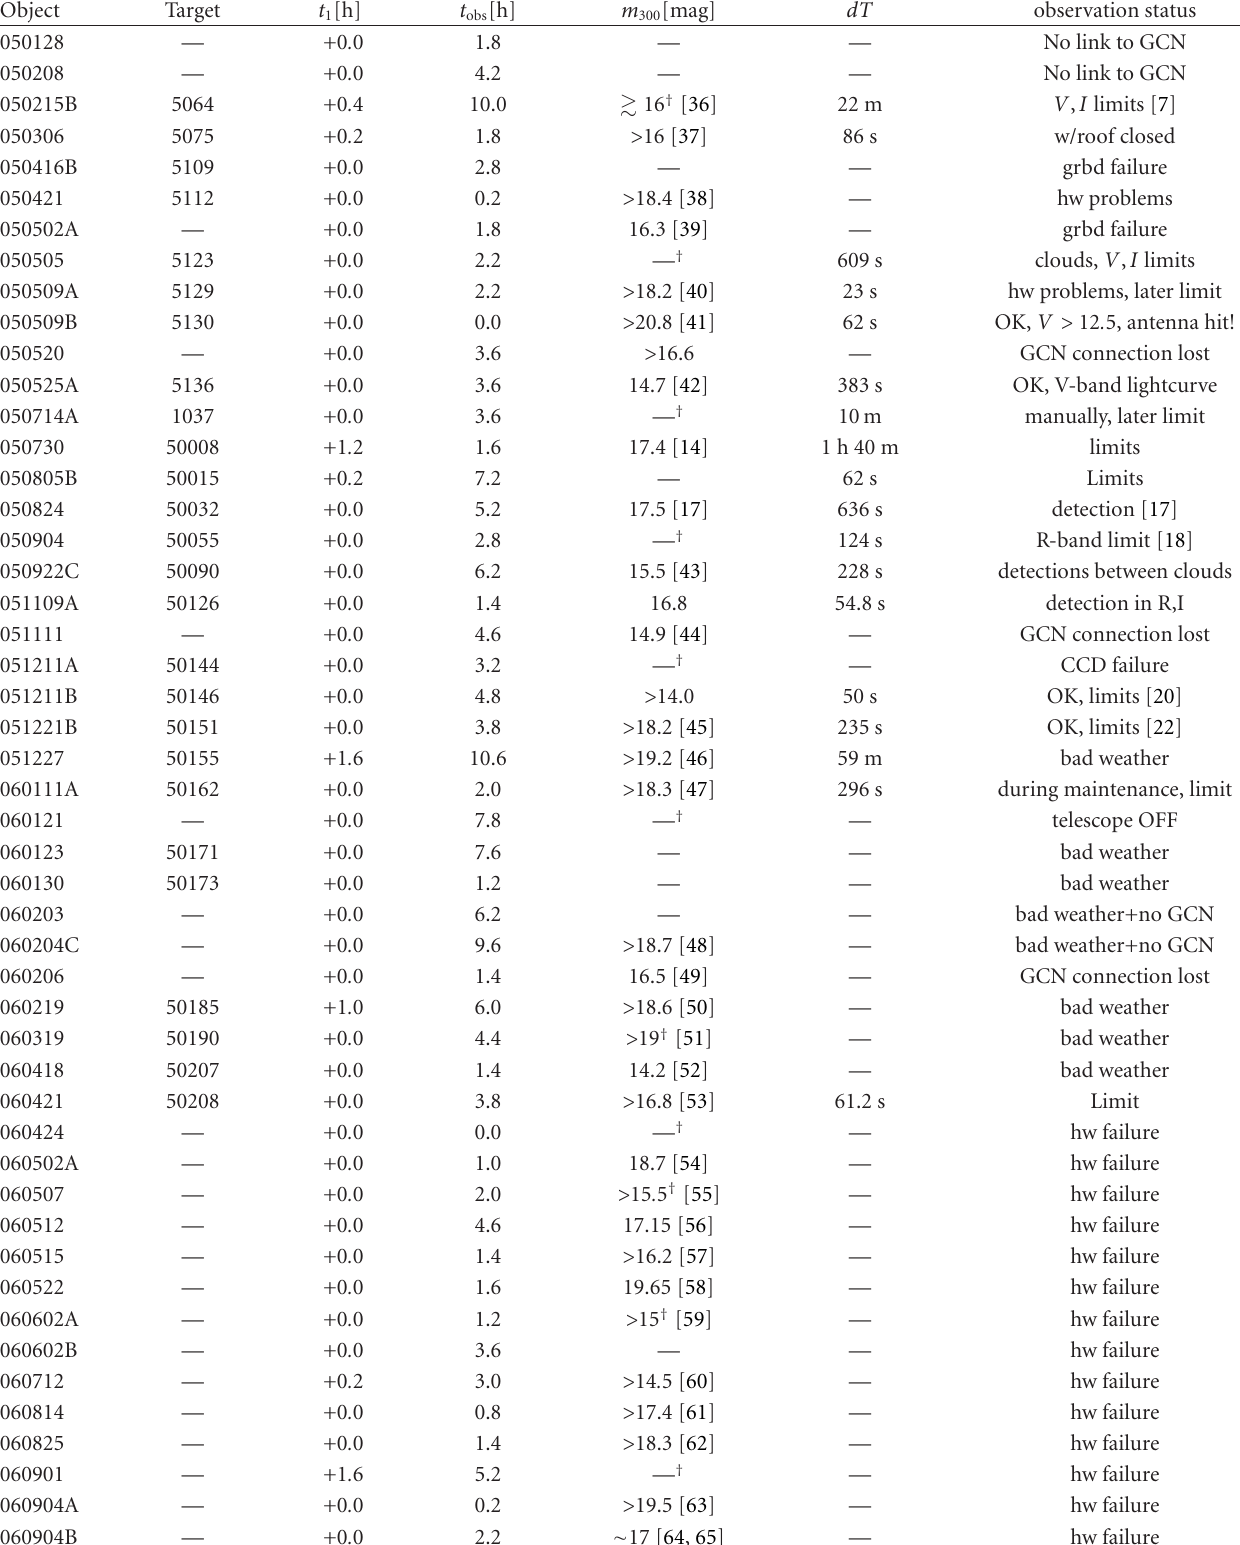
Table 3: The Great Table of BOOTES-1B GRBs. “Target” is the RTS2 target number at BOOTES-1B. t 1 is the time delay between the GRB trigger and the possible start of observation. t obs is the amount of time for which the GRB can be followed until it sets for the first time. m 300 is the known brightness of the GRB optical transient 300s after the event. dT is the delay of BOOTES-1B